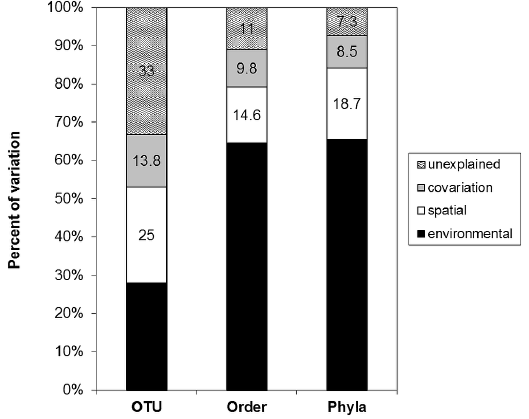
Figure 4. Variance partitioning of environmental and spatial factors shaping microbial communities at the three phyloge- netic levels (OTU, Order, Phylum).